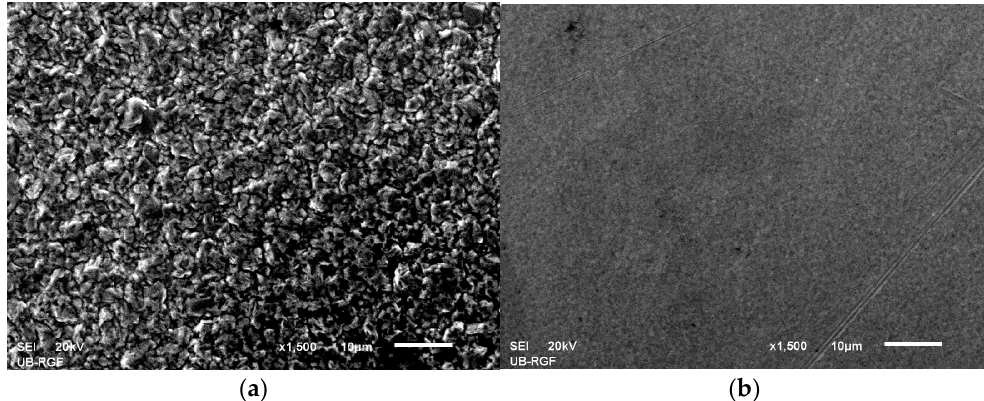
Figure 1. The morphology of 20 µm thick Cu coatings obtained by electrodeposition at a current density of 50 mA cm −2 on the brass from: ( a ) the basic electrolyte ( electrolyte I ) and ( b ) the electrolyte with leveling/brightening additives ( electrolyte II ). Magnification: ×1500.